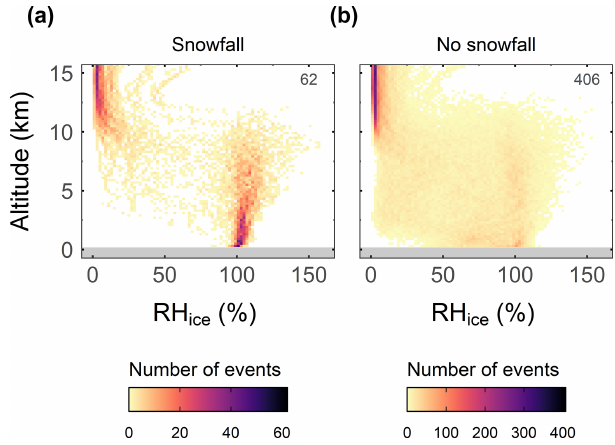
Figure 5. Relative humidity with respect to ice (RH ice ) within inter- vals of 200m height and 2% RH ice retrieved from the radiosonde profiles during (a) snowfall and (b) no-snowfall events. The total number of events for each group is provided in the upper right cor- ner of each panel. The colour scale ranges from zero to the total number of events for each group, so the colour scale for each panel is